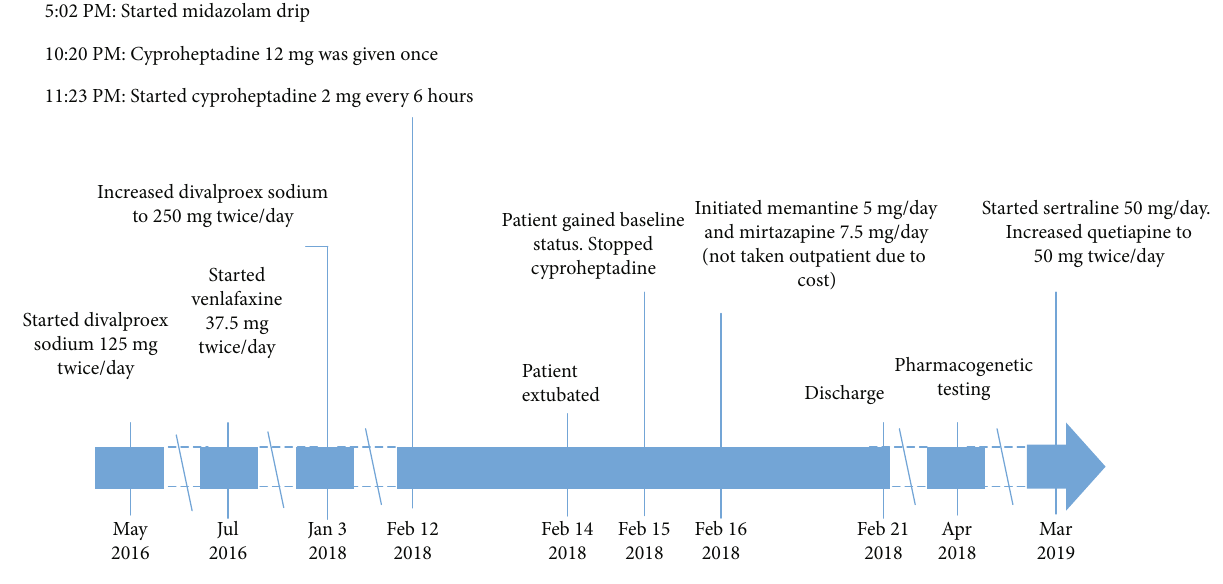
Figure 1: Timeline of patient ’ s clinical course. Table 1: Patient ’ s pharmacogenetic tests done with genotype and phenotype results.